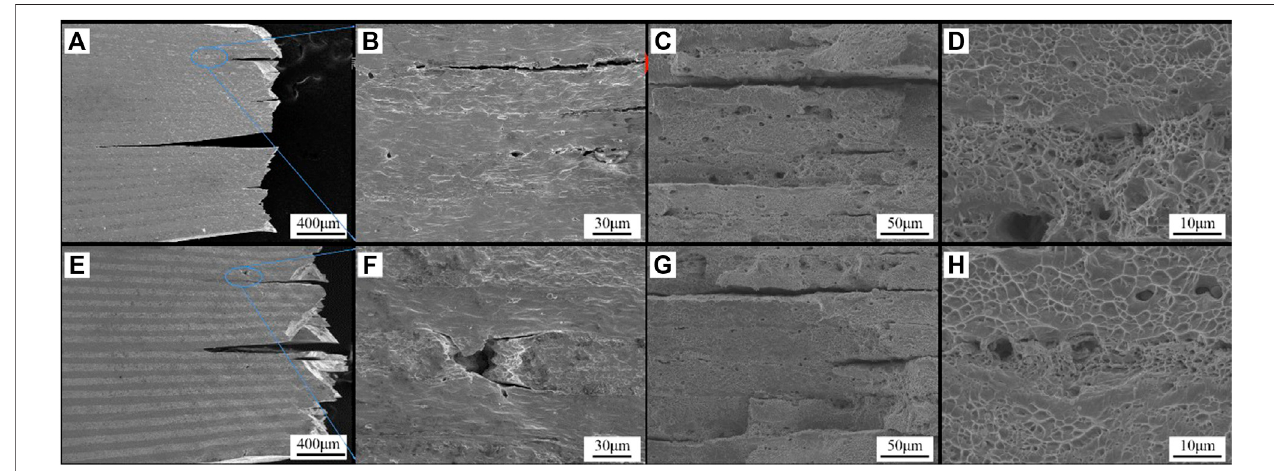
FIGURE 4 | (A – D) Fracture morphology of a hot-rolled multilayer maraging/CoCrNi composite, (E – F) fracture morphology of ageing treat multilayer maraging/ CoCrNi composite.